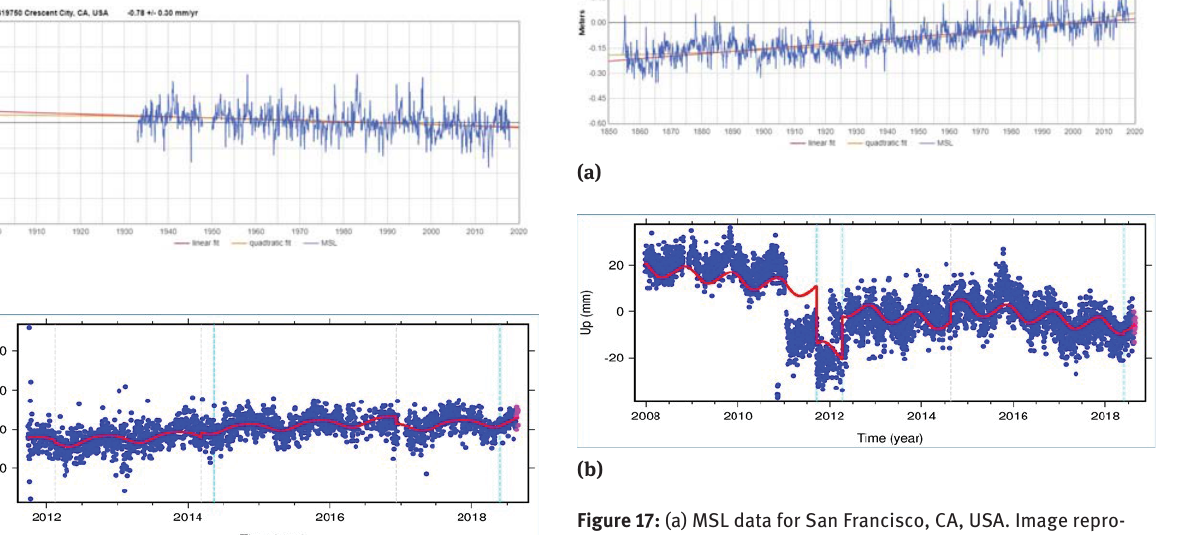
Figure 17: (a) MSL data for San Francisco, CA, USA. Image repro- duced modified after [4]. (b) GNSS time series for UCSF. Image re- produced modified after